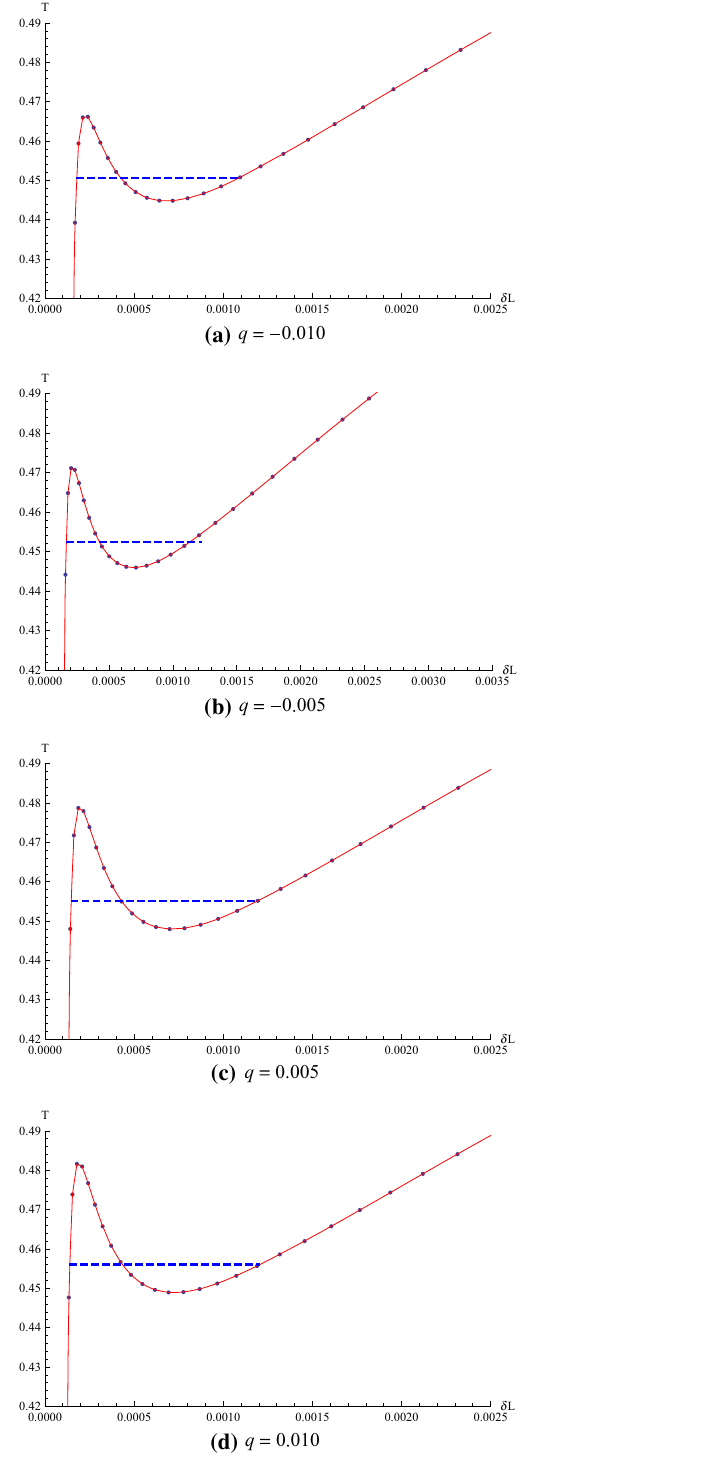
Fig. 4 Plots of isocharges in the T – δ L plane for θ 0 = 0 . 50. The blue dash line corresponds to the temperature of the first order phase transition for Q < Q C . a Q = 0 . 0286384 < Q C . b Q = 0 . 0338006 < Q C . c Q = 0 . 0429513 < Q C . d Q = 0 . 0470977 < Q